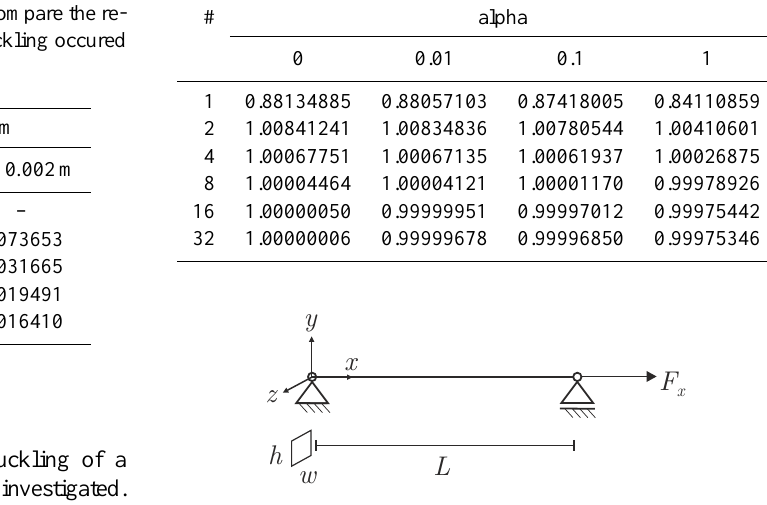
Figure 8. Simply supported beam under axial pre-stress in Sect. 6.7 investigated for eigenfrequency